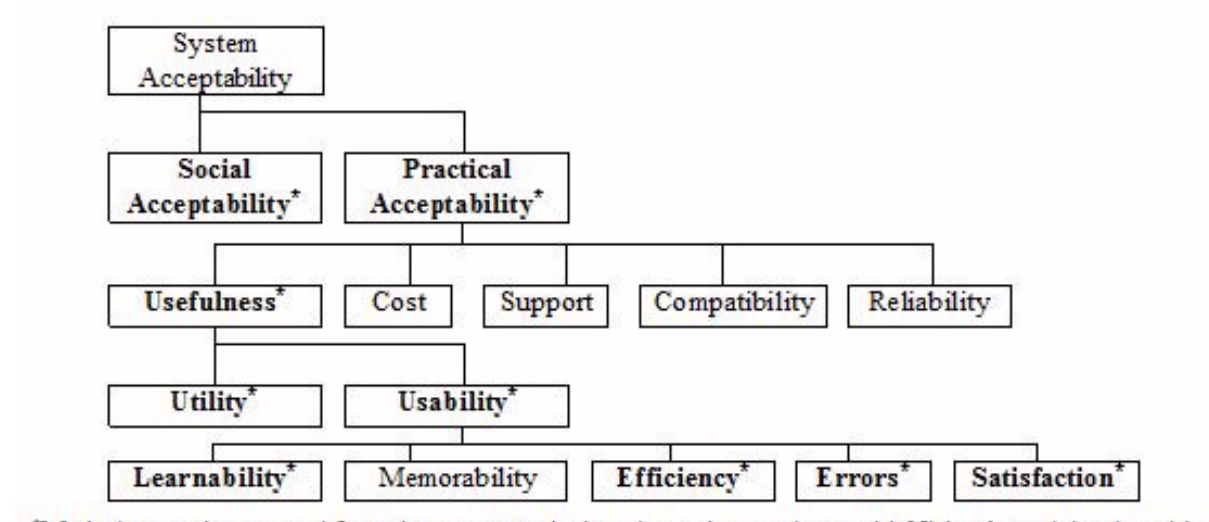
Figure 1. Model of System Acceptability (modified from